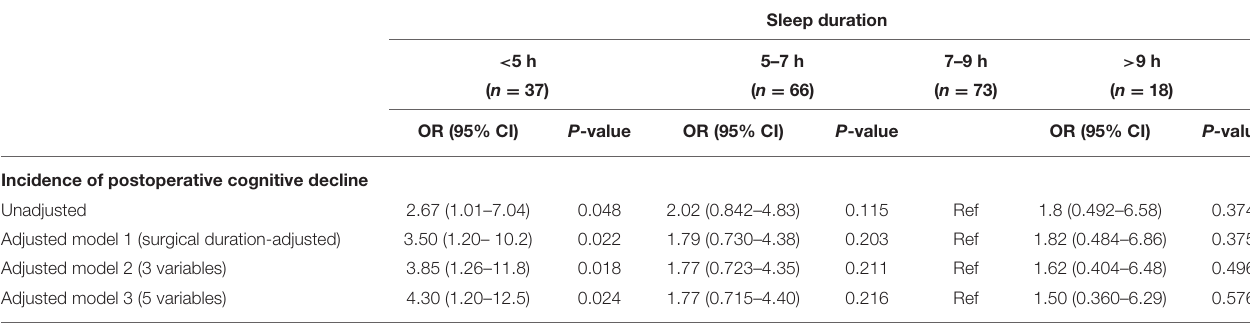
TABLE 2 | Unadjusted and adjusted incidence of cognitive decline according to sleep duration.